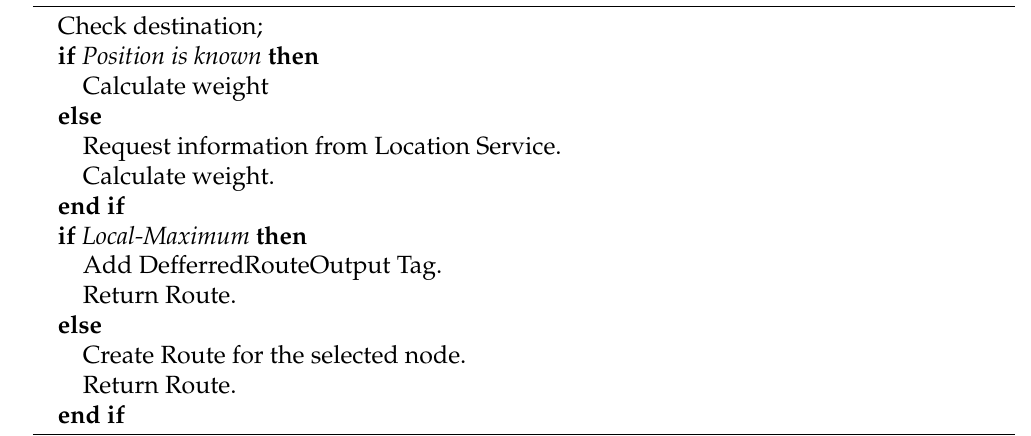
Algorithm 1 A packet to be routed in the